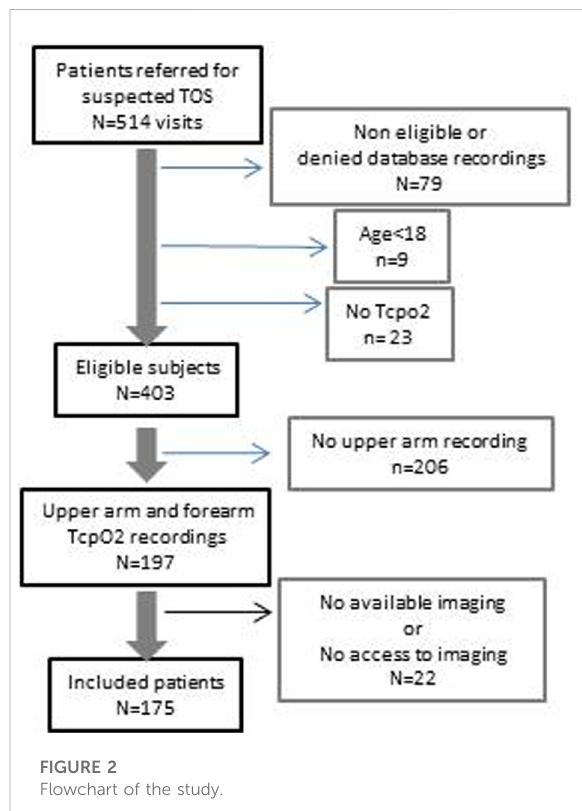
FIGURE 2 Flowchart of the